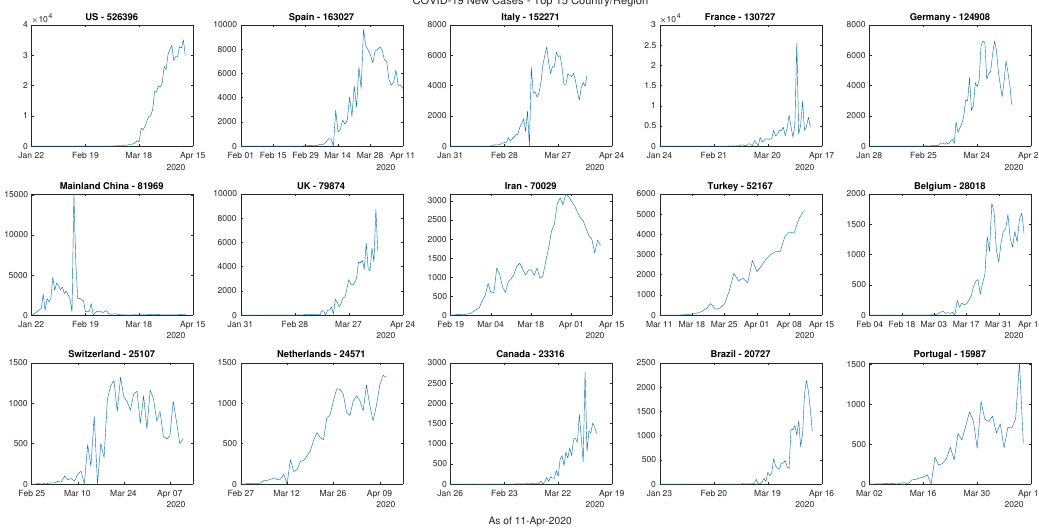
Figure 13. Propagation of the virus in 15 most reported active cases as of 11 April